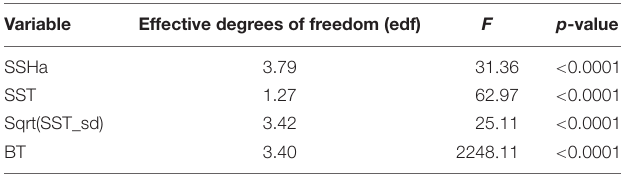
TABLE 6 | Summary statistics from the final GAMM model that characterizes the environmental drivers of summer offshore migrations by hawksbill turtles ( n =